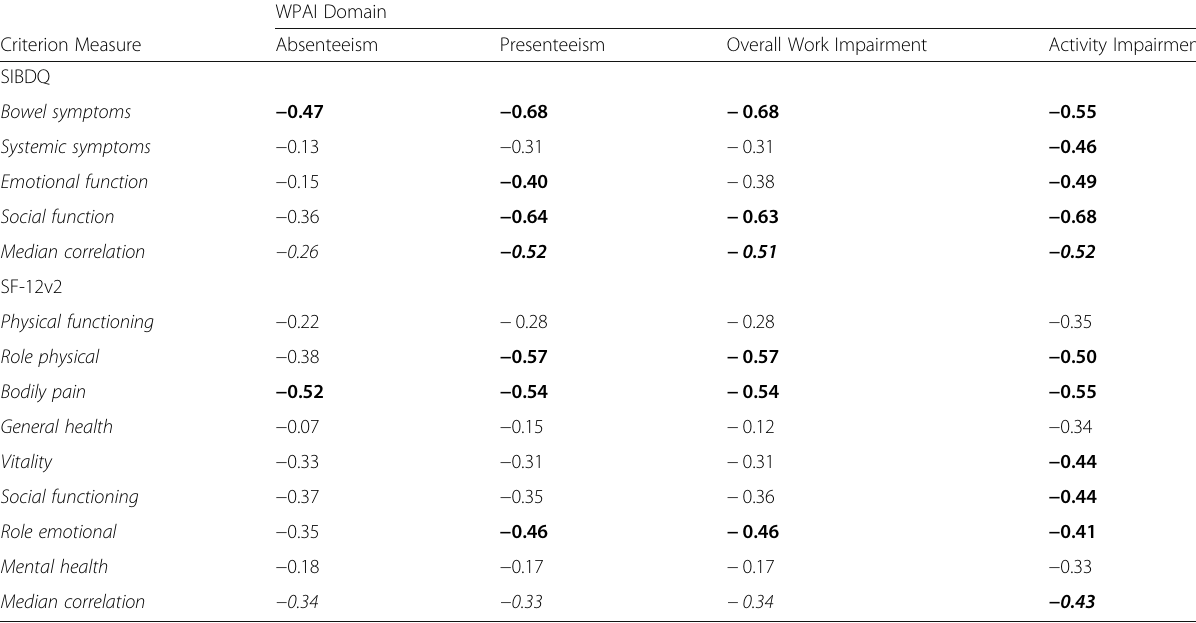
Table 3 Convergent validity: Spearman rank-order correlation coefficients between WPAI domains and criterion measures of health- related quality of life